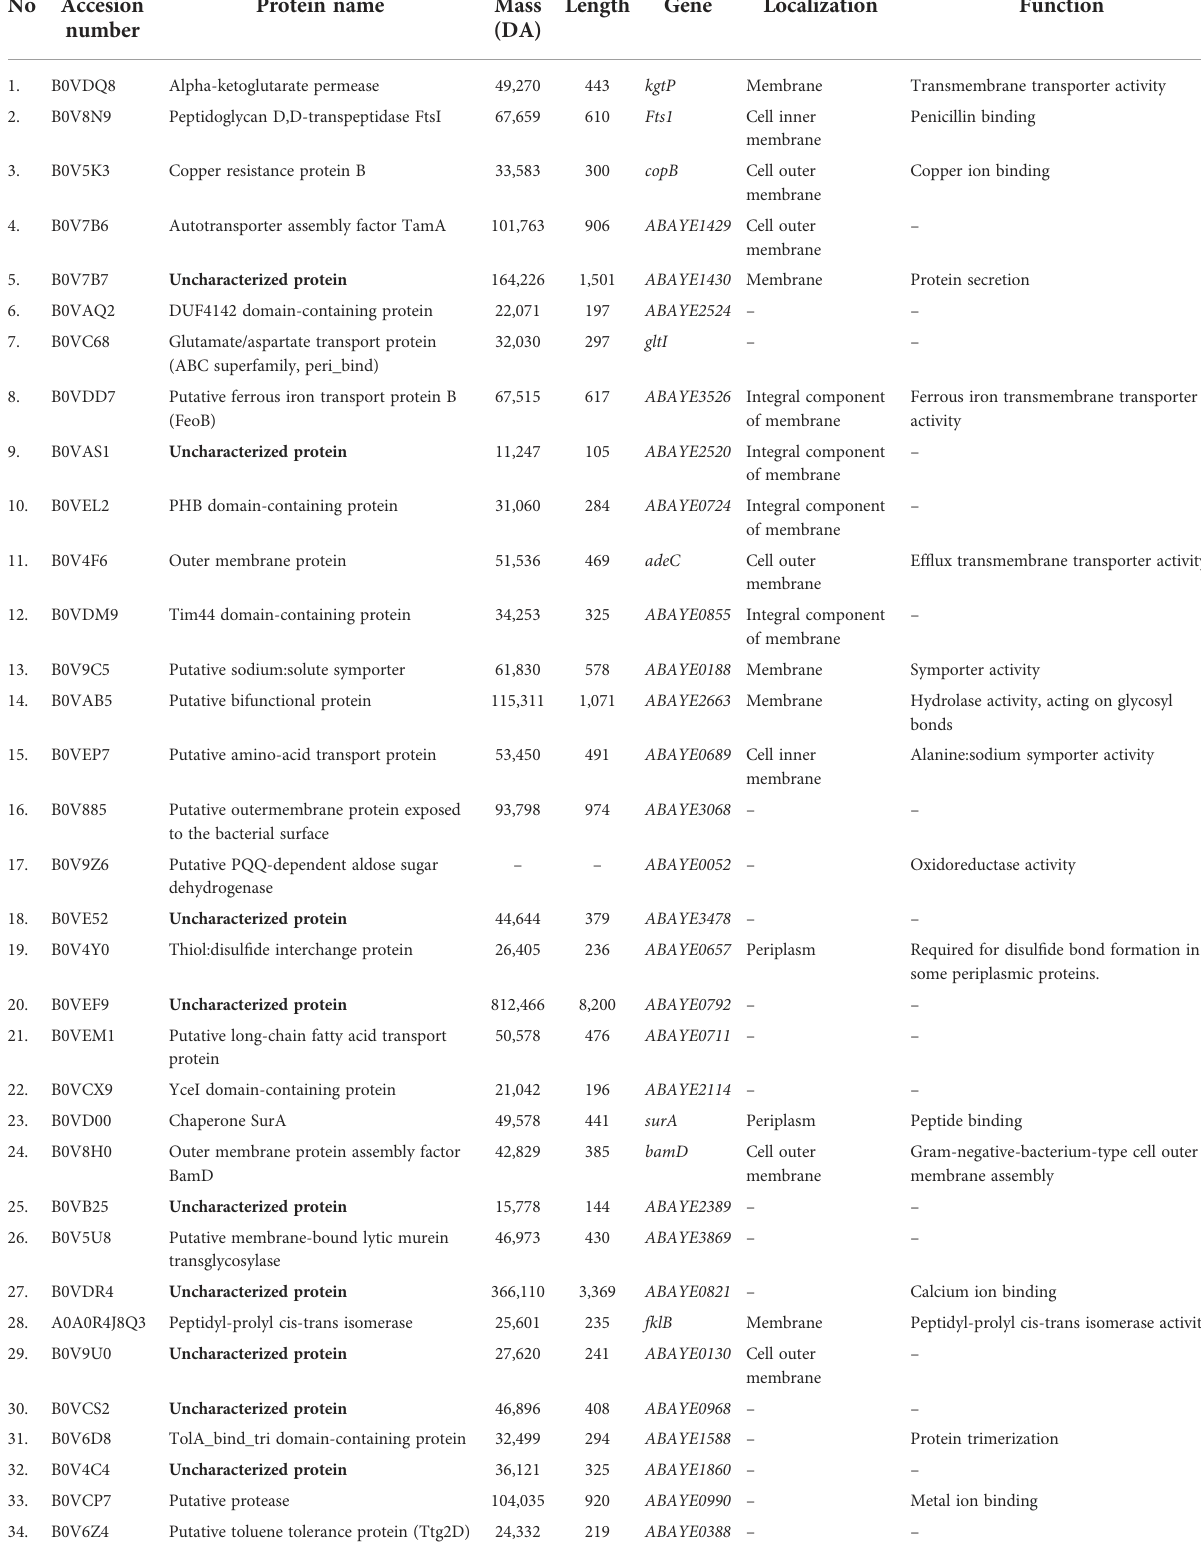
TABLE 1 List of the 34 identi fi ed resistant A. baumannii outer-membrane and secretome proteins, their molecular mass (Da), amino acid lengths, encoding genes, cell localization, and annotated